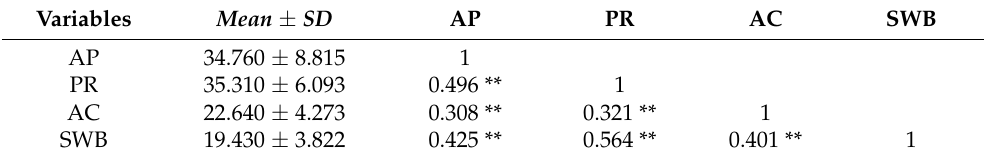
Table 2. Mean, standard deviation, and Pearson correlation of each